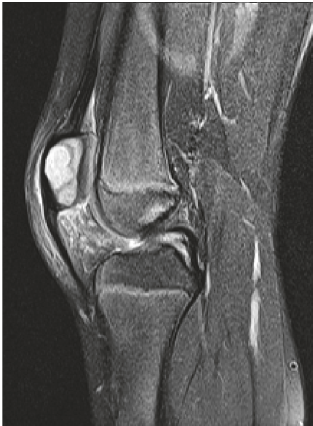
Figure 2: MRI showing a sharply limited enhancement of the patella. The radiologist suspected a